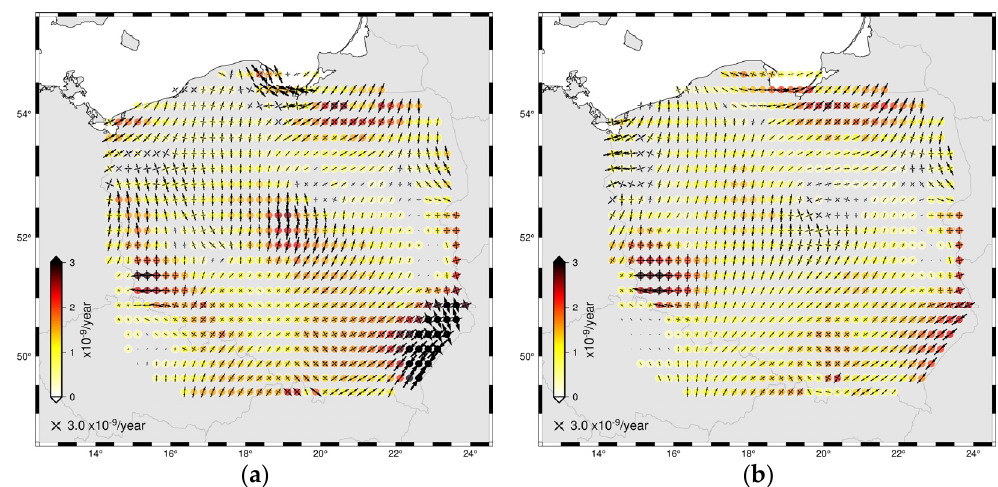
Figure 8. GPS strain rate maps including dilatation strain for SBF_15 ( a ) and SBF_25 ( b ).